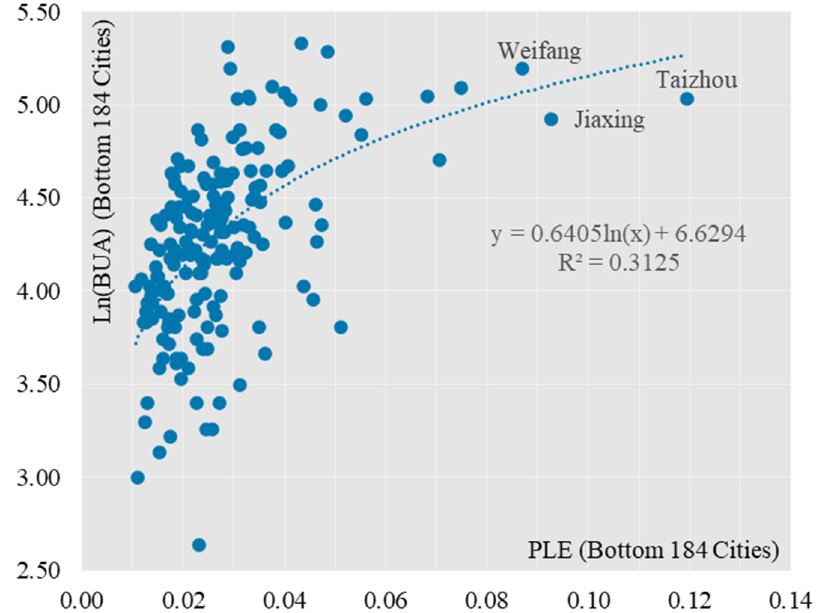
Figure 6. Scatterplot of two variables PLE and BUA (analysis of 184 small and medium-sized cities).